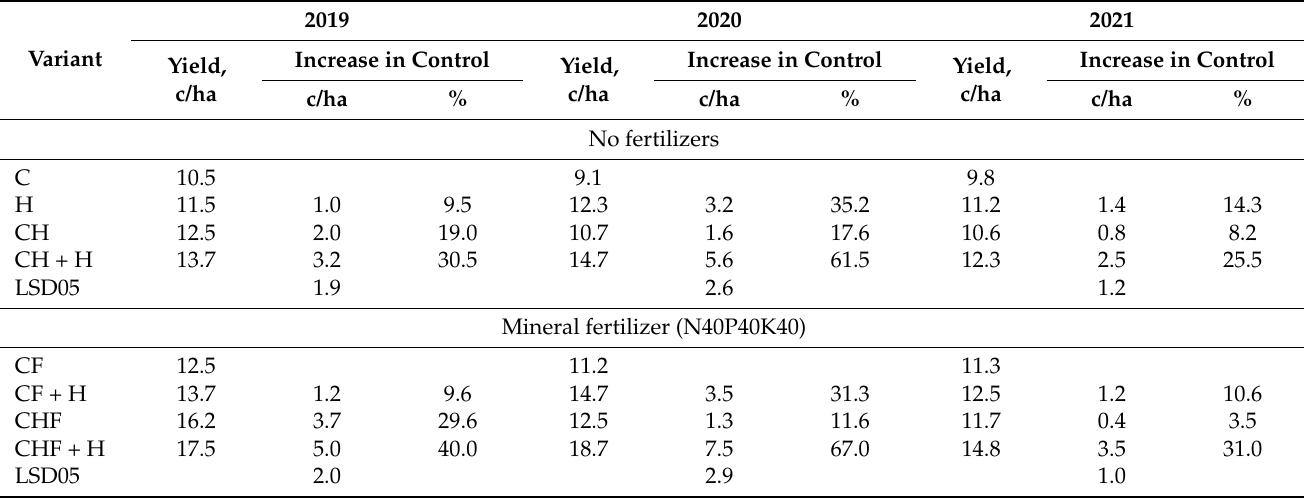
Table 4. Yield of chickpeas by variants of the experiment with a humic preparation.